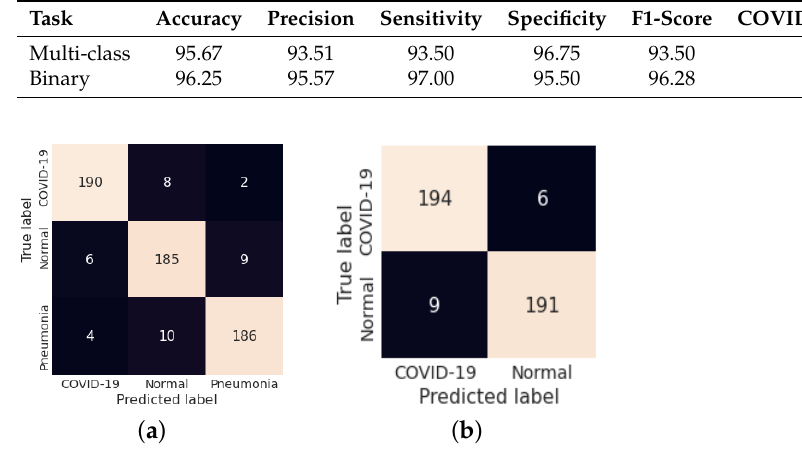
Figure 11. ( a , b ) Confusion matrix obtained for both cases on